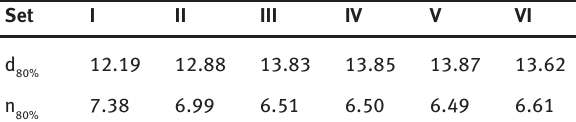
Table 3: Product grain size, degree of fineness Set I II III IV V